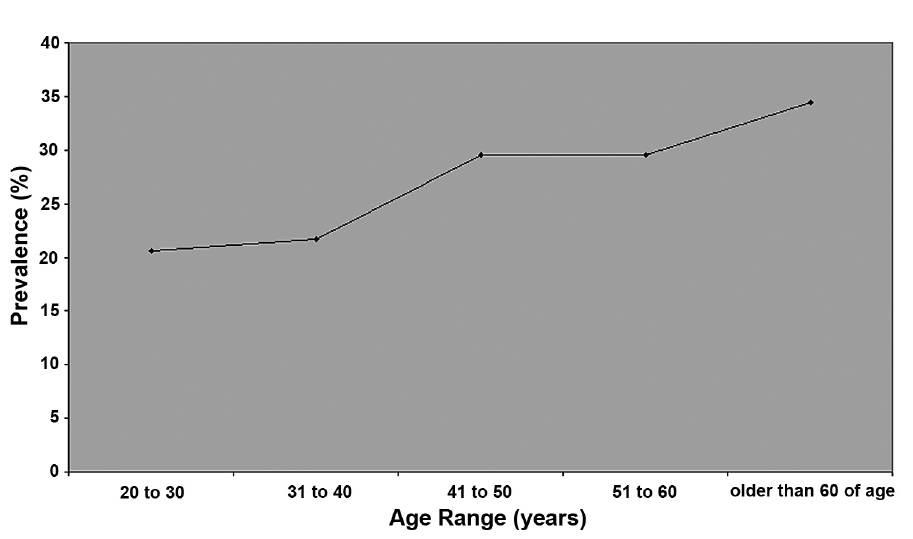
Figure 1 – Urinary incontinence prevalence in relation to